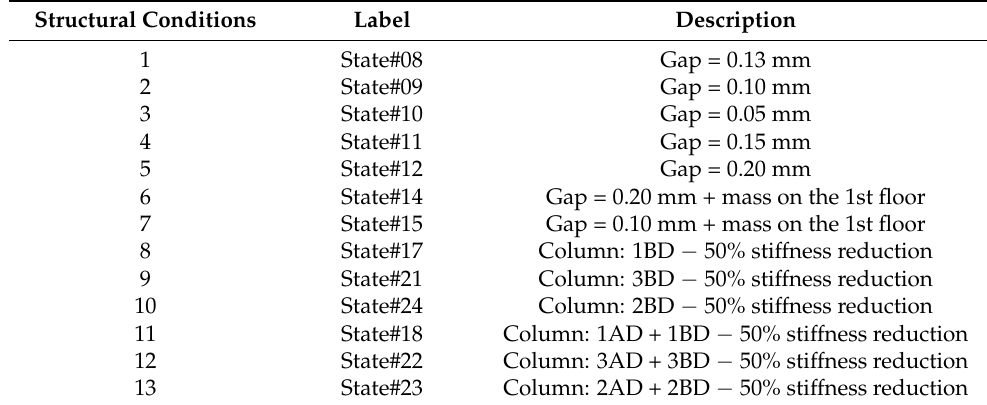
Table 1. Different scenarios of the structure.